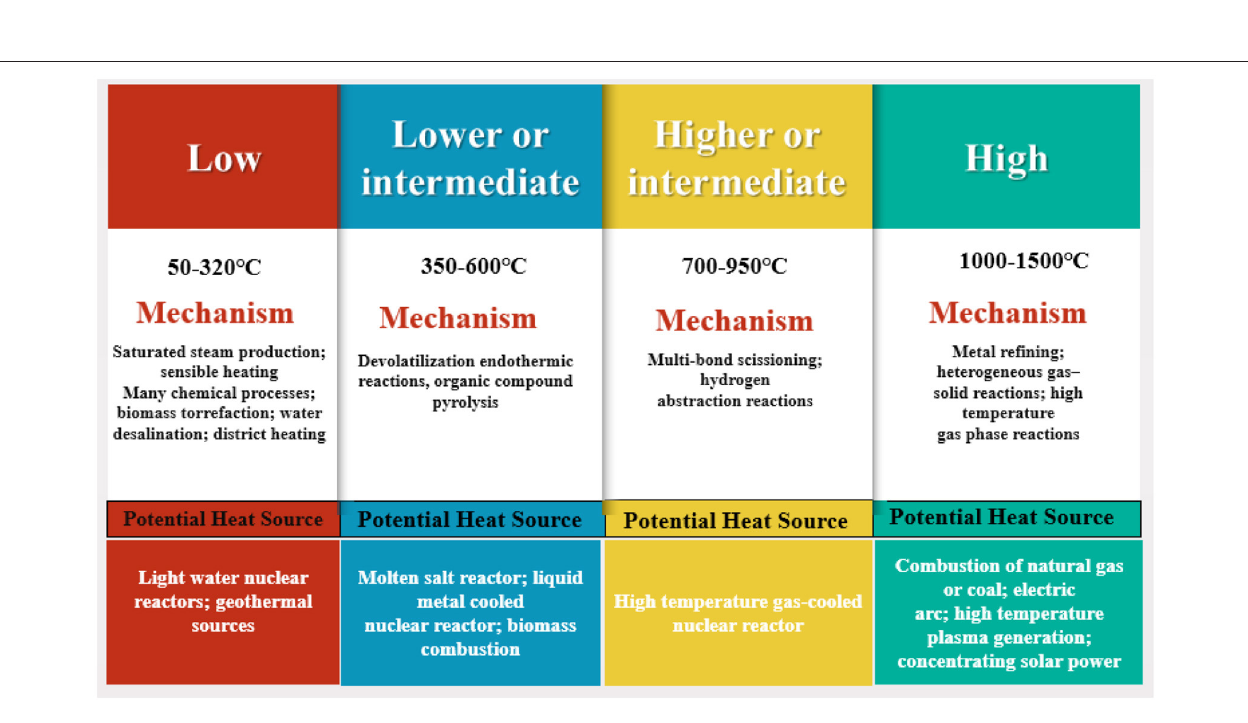
Frontiers in Sustainable Cities |